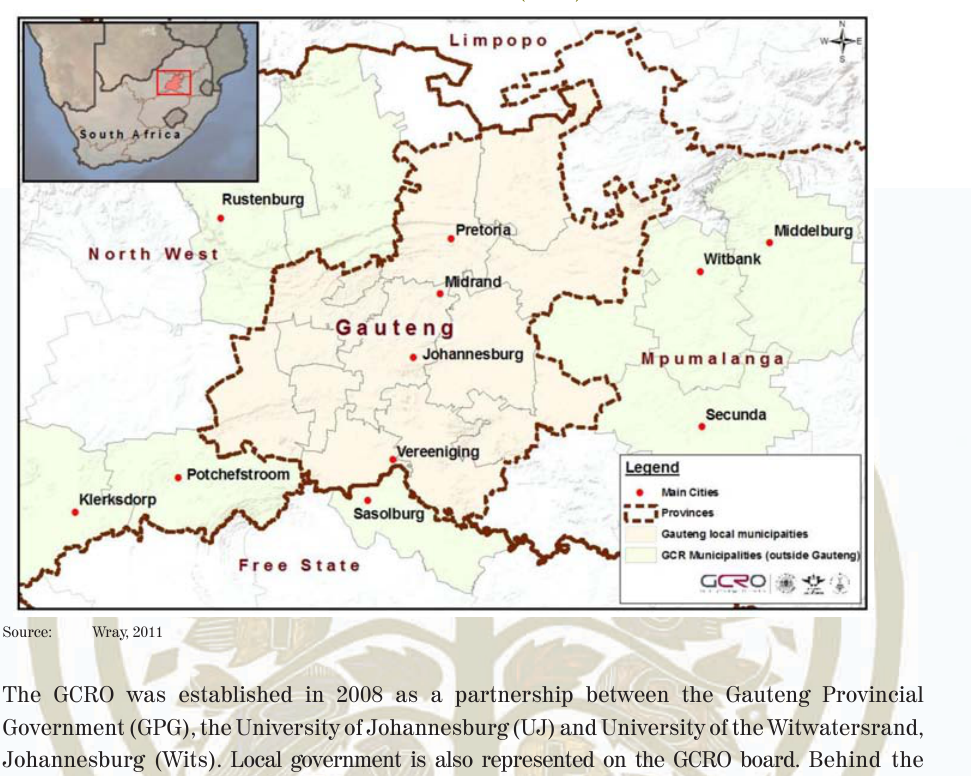
FIGURE 1: THE GAUTENG CITY-REGION